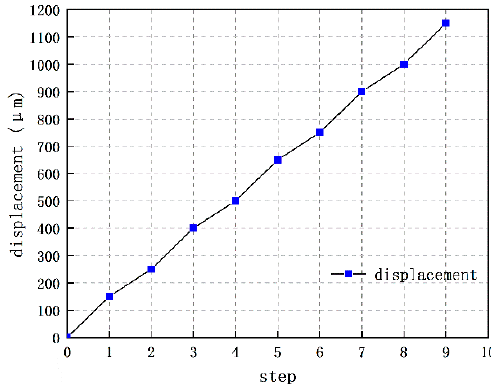
Figure 16. The displacement along with the steps driven by actuator.